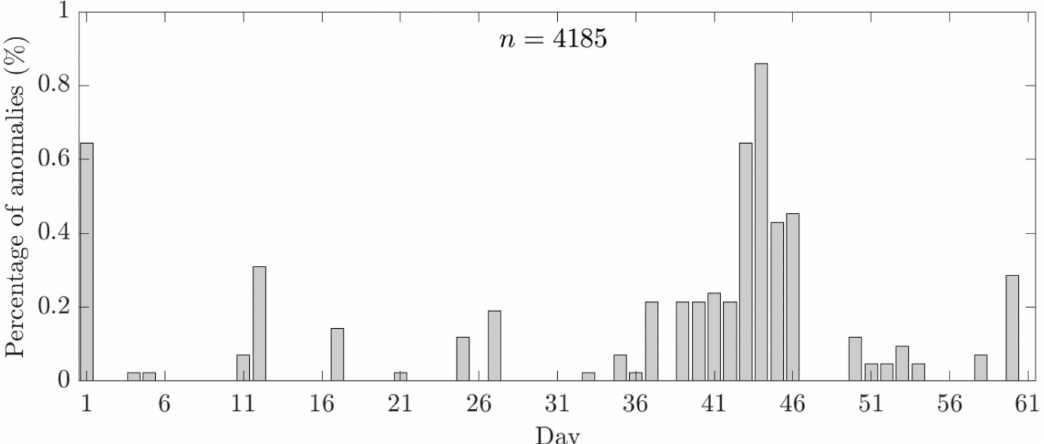
Figure 6. Percentage of anomalies during no-earthquake (i.e., the control group) periods throughout 61 days of